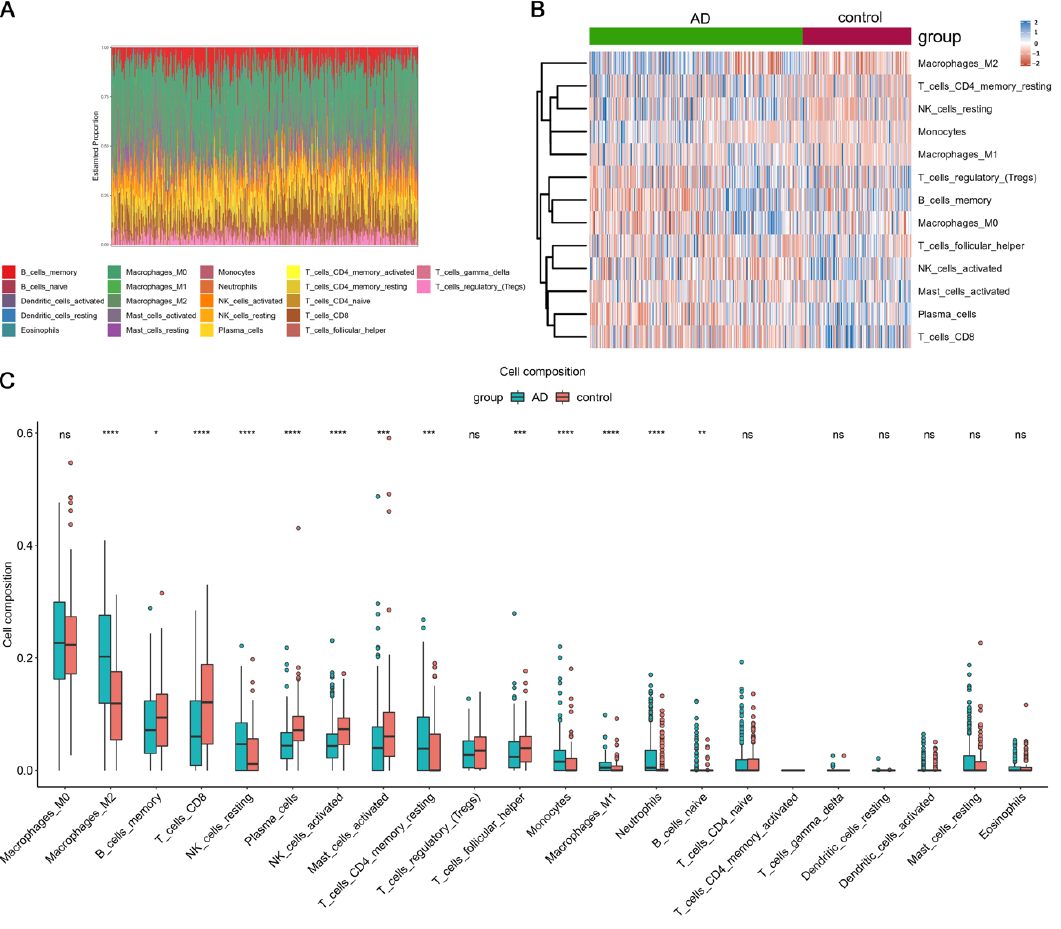
Figure 3. Evaluation of brain-infiltrating immune cells. ( A ) Boxplot of distribution of immune cells in each sample, the height of each color represents the percentage of such cells in the sample. ( B , C ) Heatmap and violin plot showing the distribution of 22 types of immune cells in AD patients and HCs. ns p > 0.05, * p < 0.05, ** p < 0.01, *** p < 0.001, **** p < 0.0001 compared to HCs.